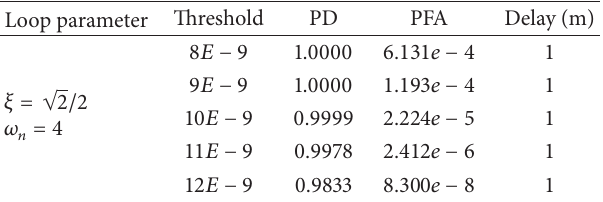
Table 1: Detection performance for phase jumping.